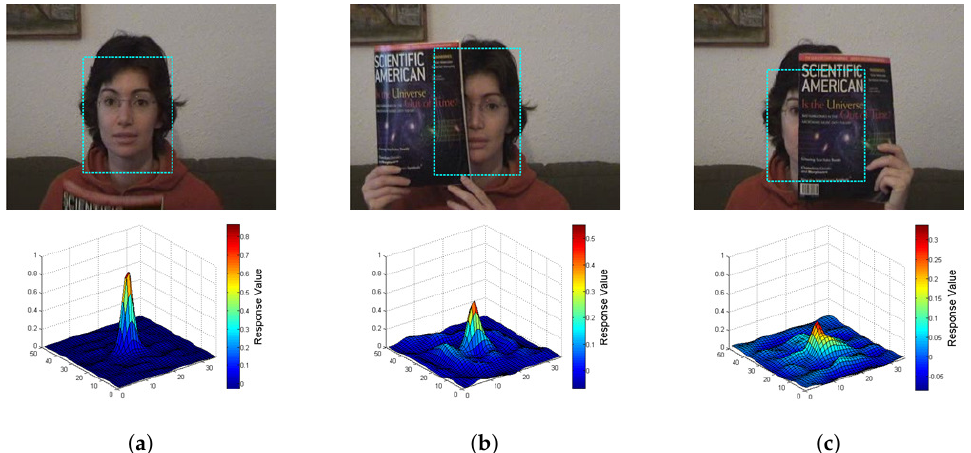
Figure 1. Illustration of the occlusion caused by a dissimilar object in the faceocc1 sequence. The z -axis range of the response map is the same, in order to compare the differences in the peak values in different occlusion states. ( a ) Non-occlusion target and its response map; ( b ) Slight occlusion target and its response map; ( c ) Heave occlusion target and its response map.